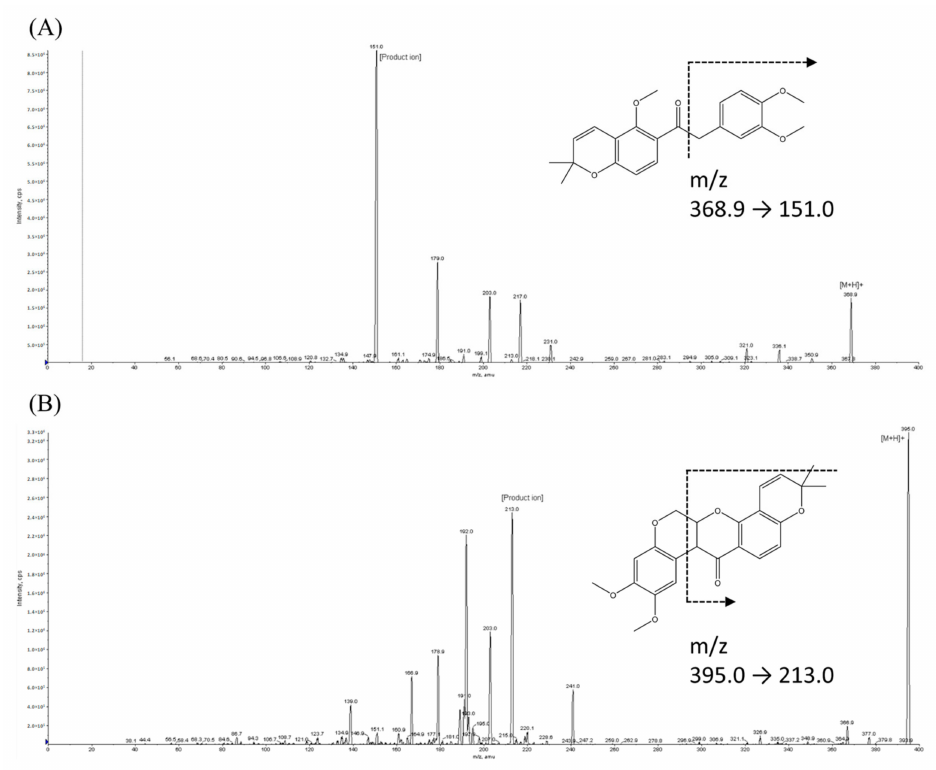
Figure 1. The product-ion scan spectra and proposed multiple reaction monitoring (MRM) transitions of ( A ) SH-1242 and ( B ) deguelin, (the internal standard).